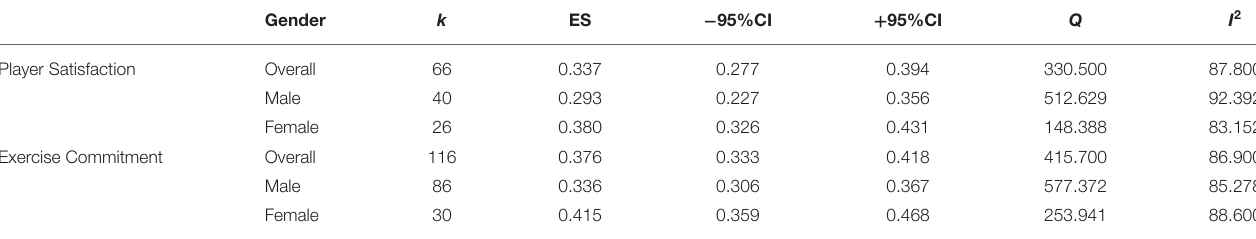
TABLE 1 | Results of meta-analysis of the relationships between coach leadership behavior (MLQ) and player satisfaction and exercise commitment by gender. Gender Player Satisfaction